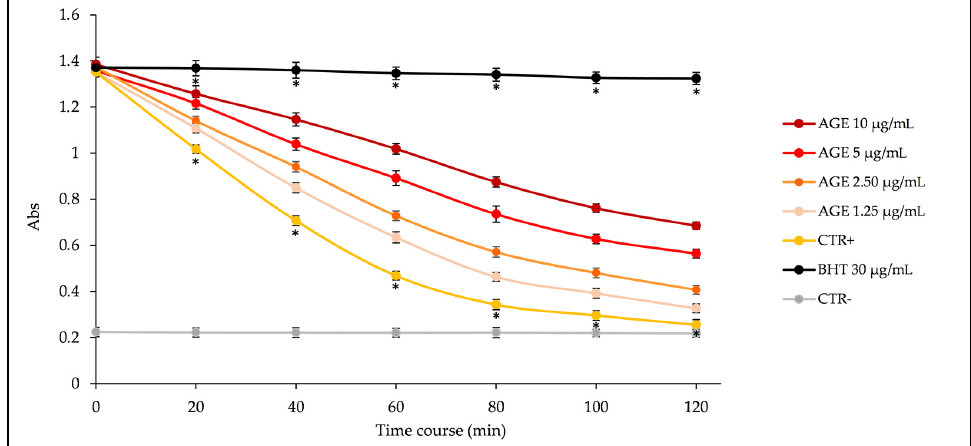
Figure 2. β -Carotene bleaching kinetic curves of A. glutinosa bark extract (AGE, 1.25–10 µg/mL) compared to the reference standard butylated hydroxytoluene (BHT) 30 µg/mL, positive control (CTR+), which consist in the same emulsion with methanol instead of sample and negative control (CTR-), which consist in the same emulsion without β -carotene and with methanol instead of sample. * p < 0.001 vs. AGE (1.25–10 µg/mL).